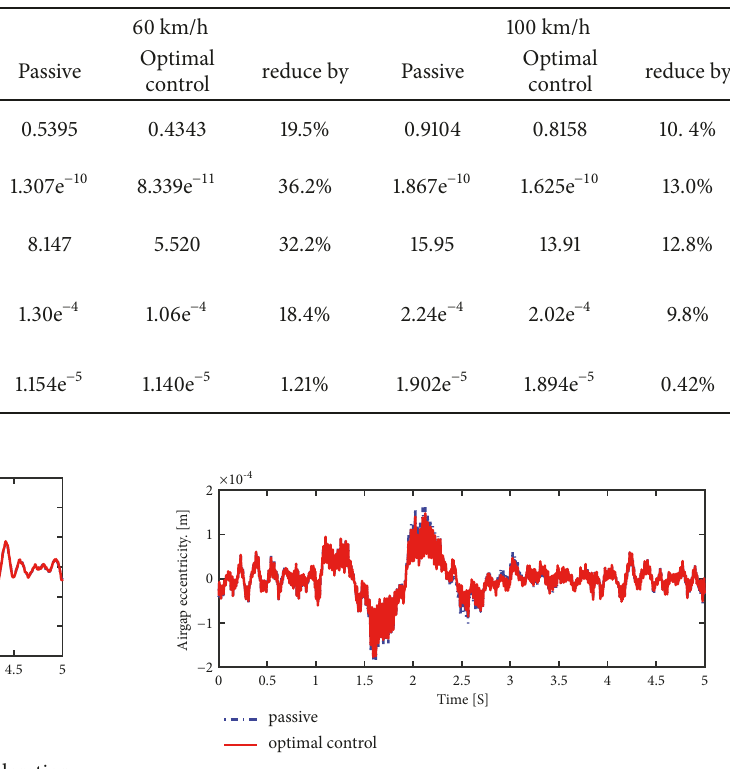
Figure 19: Time history response of airgap eccentricity.